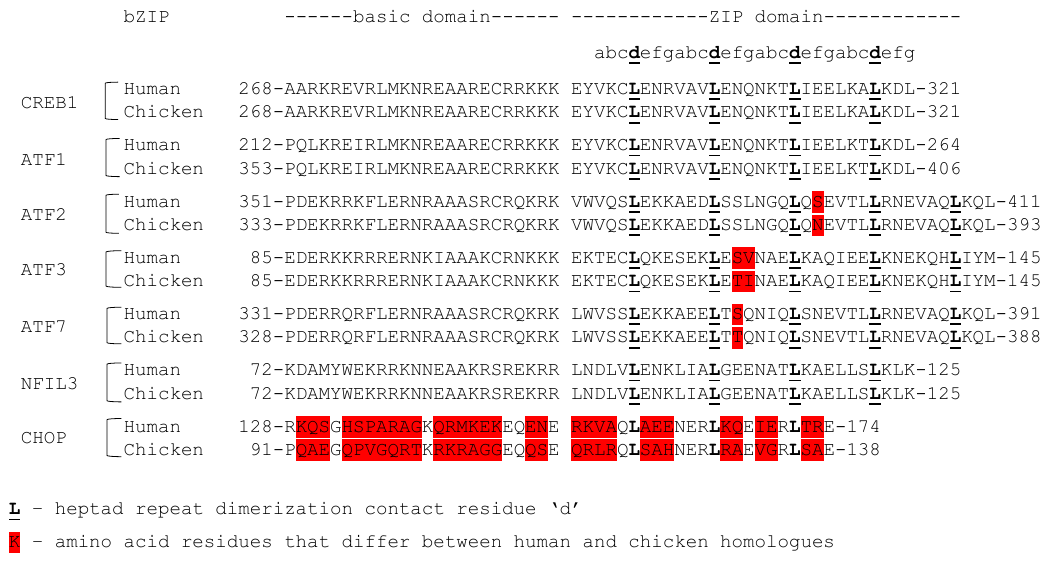
Figure 4. Amino acid similarity of human and chicken bZIP proteins. Amino acid sequences were obtained from the National Center for Biotechnology Information gene database. CREB1